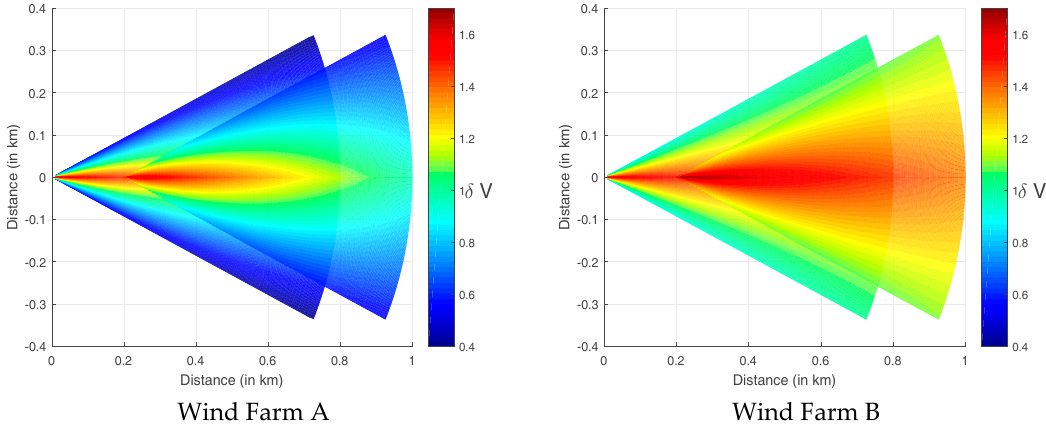
Figure 6. Simulation of velocity deficits δ V with two consecutive turbines for an undisturbed wind speed of 7 m/s coming from the left, wind farm A ( left ) and wind farm B ( right ).